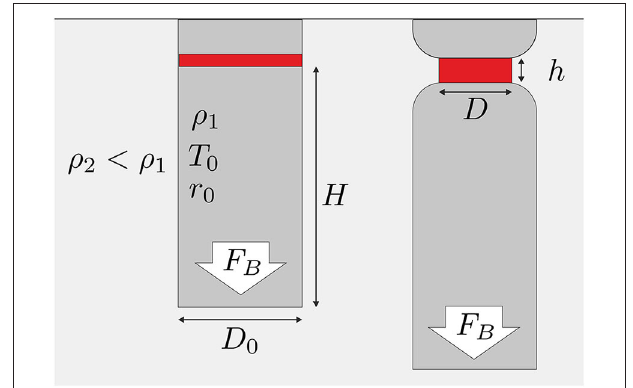
FIGURE 1 | Model setup. (Left) Initial configuration of a slab with length H and thickness D 0 . The red region is the necking region with height h 0 and thickness D 0 . (Right) Later stage, at which the thickness D of the necking region is significantly reduced and its height h